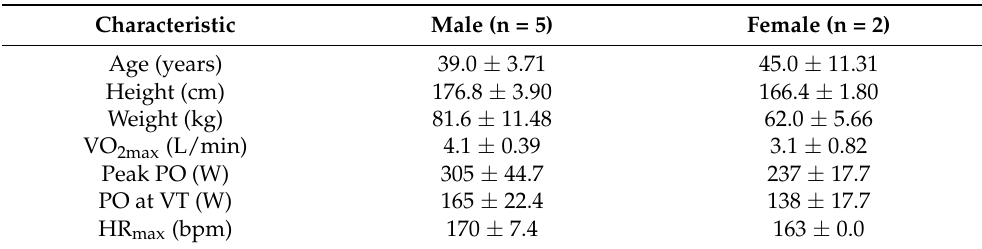
Table 1. Means ± standard deviations of the descriptive characteristics of men and women during maximal incremental exercise